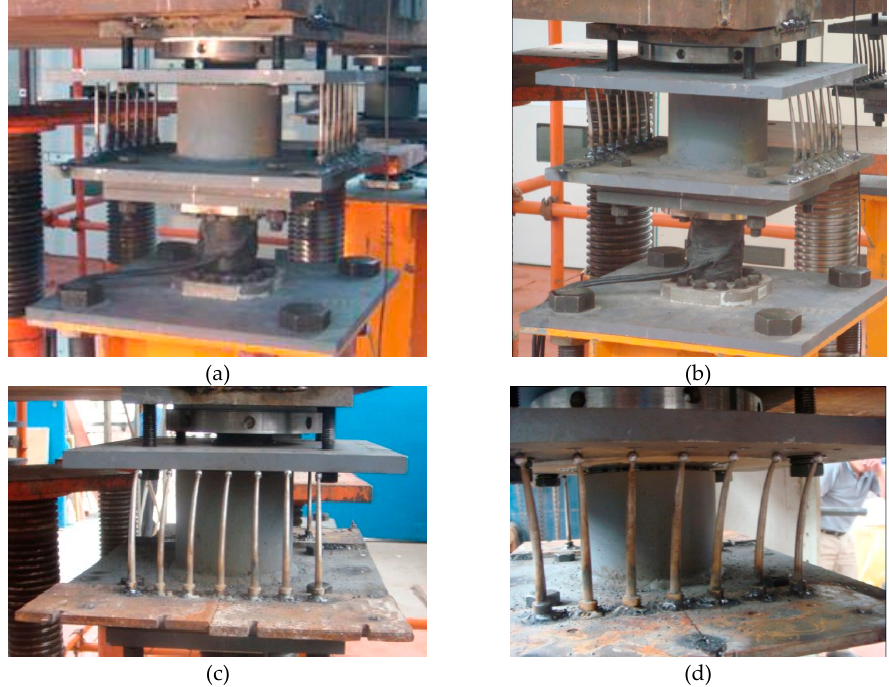
Figure 10. Rubber bearing and the three-direction-force transducers before and after the experiment. ( a ) Rubber bearing and the three-direction-force transducers before the experiment, ( b ) rubber bearing and the three-direction-force transducers after the experiment, and ( c , d ) the detailed deformation of the three-direction-force transducers after the experiment.